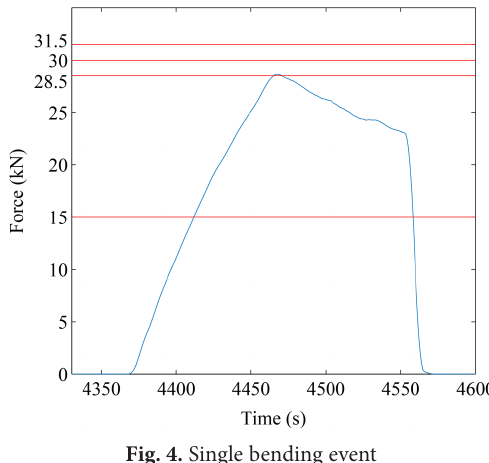
Fig. 4. Single bending